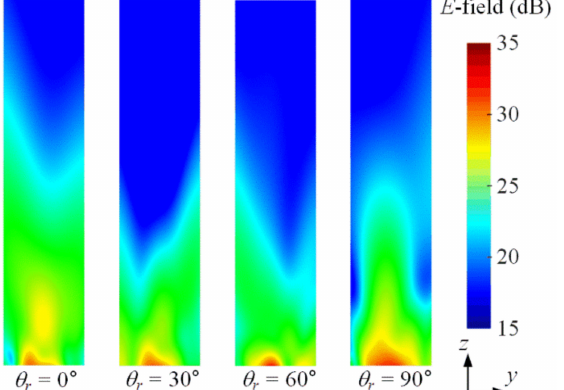
Figure 11. E-field distributions according to θ r in the zy -plane.